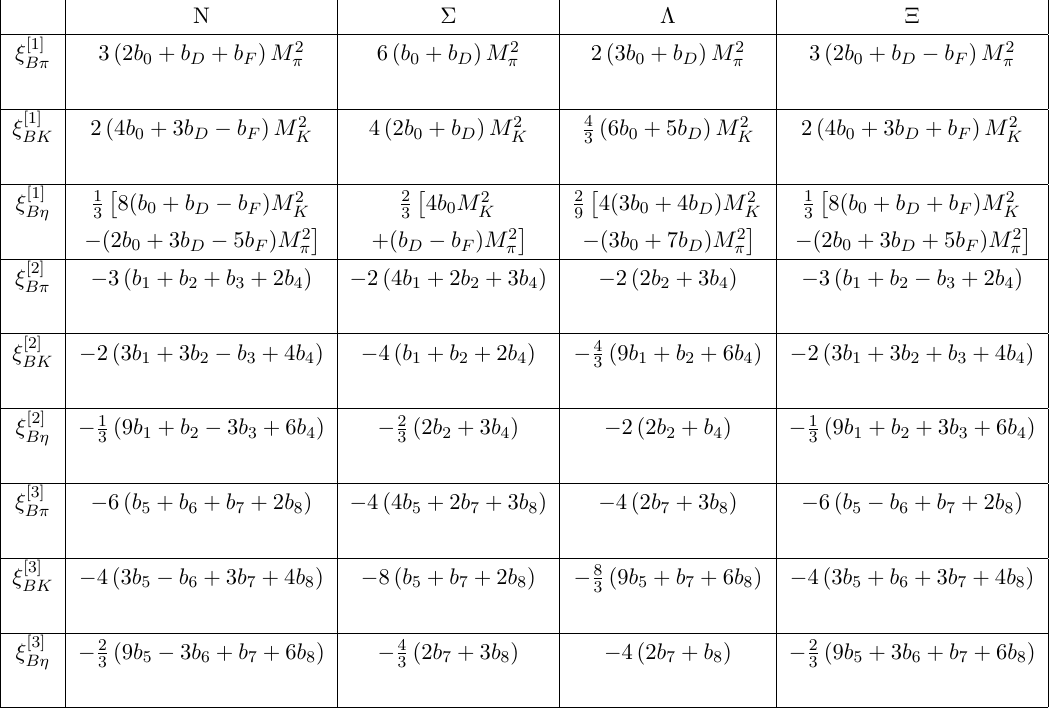
Table 3 . Coe(cid:14)cients of the O ( p 4 ) tadpole diagrams.